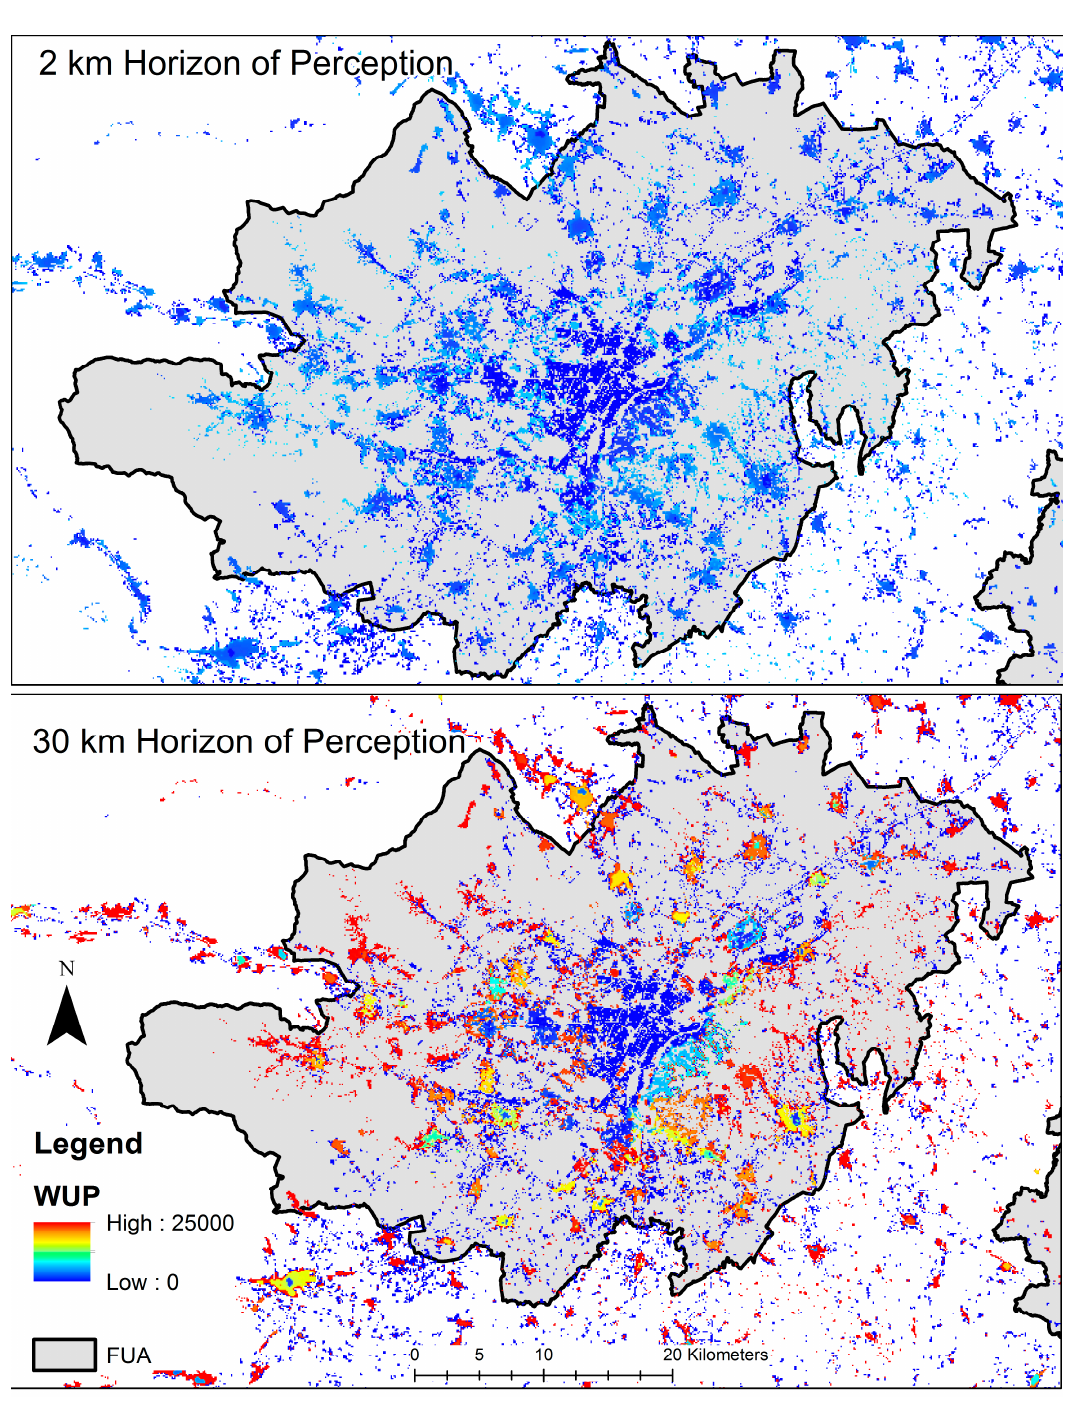
Figure 2. WUP values for the city of Turin, Italy for horizons of perception of 2, and 30 km.